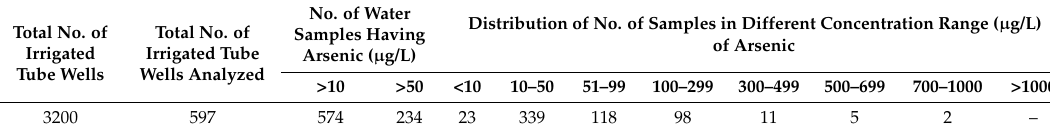
Table 1. Distribution of arsenic in water from irrigated tube wells in Deganga block, North 24 Parganas, West Bengal,